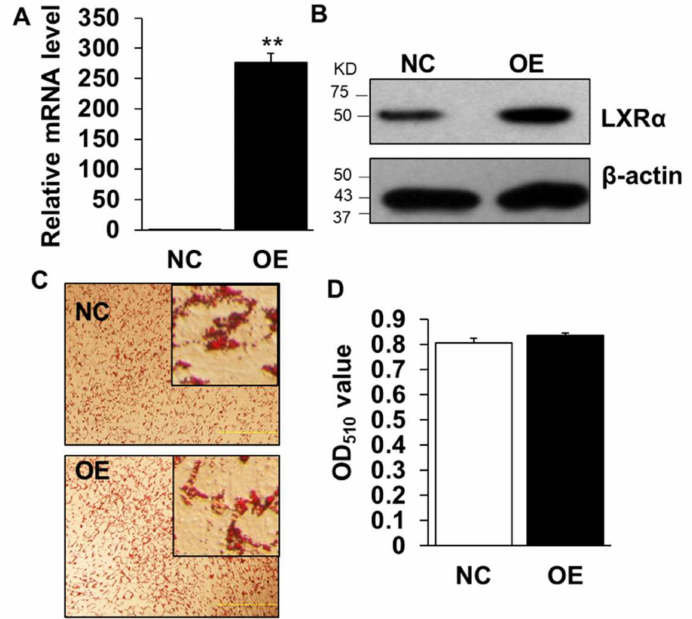
Figure 4. Overexpression of LXR α does not impact on goat intramuscular adipocyte differentiation. ( A , B ) The overexpression efficiency of LXR α at mRNA and protein level ( n = 6). ( C , D ) The Oil Red O staining ( × 100) and lipid accumulation between control and overexpression treatment intramuscular adipocyte cells ( n = 4). Data are shown as the means ±